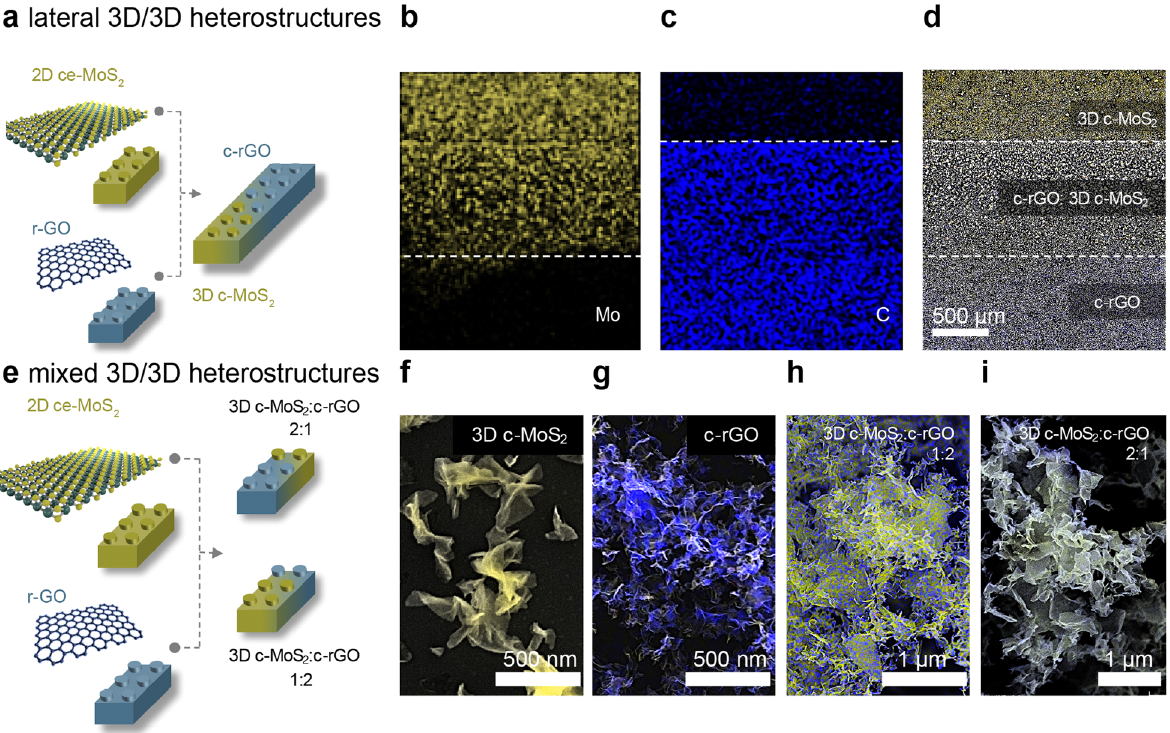
Fig. 3 Utility of E-3D printing-DROPS. a Schematic illustration demonstrates the formation of lateral 3D/3D heterostructures again via the dual-sourced DROPS deposition with controlled depositions of 2D inks along the in-plane direction. EDS mapping clearly reveals the spatial distribution where individual building blocks on both ends — that is, b Mo, false-color in yellow, and c c-rGO, false-color in blue, gradually converge into lateral heterostructures in the middle ( d ). In addition, the versatility and fl exibility of DROPS allow us to further extend the material selections from pure c-MoS 2 and c-rGO to the combination of both with compositionally engineered ratios as suggested in the scheme ( e ). 2D inks can be compositionally engineered to create composite inks with desired ratios. Corresponding EDS mappings show the formation of f pure 3D c-MoS 2 ; g pure c-rGO; h mixed 3D/3D heterostructure with c-MoS 2 :c-rGO = 1:2; and i mixed 3D/3D heterostructure with c-MoS2:c-rGO = 2:1,